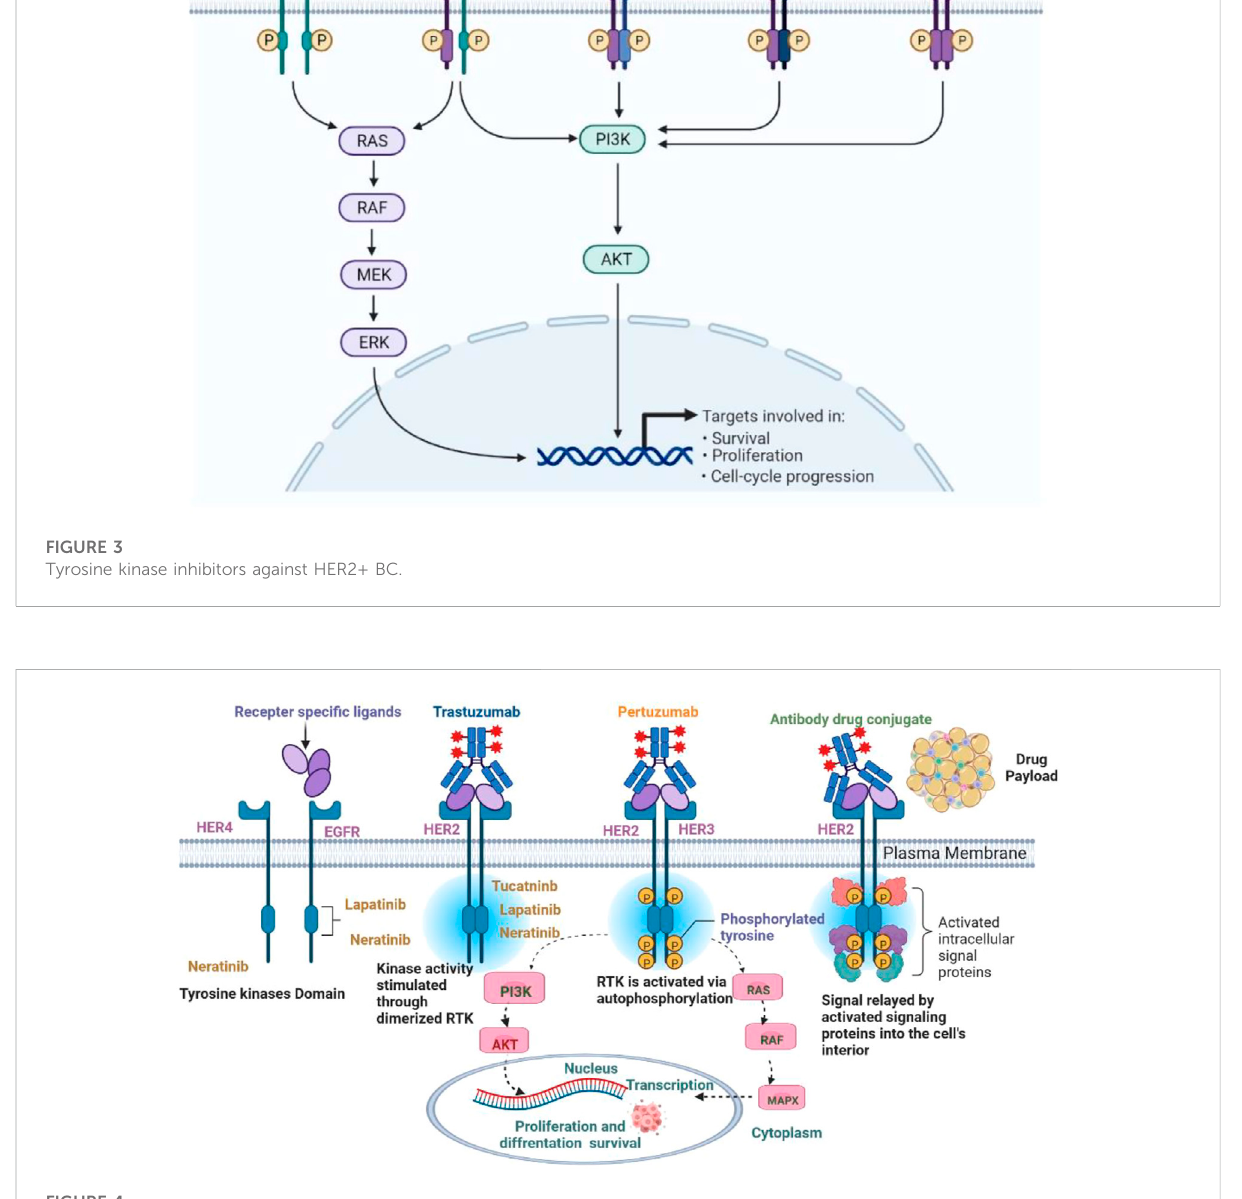
multiple targets as shown in Figures 3, 4. Sorafenib targets vascular endothelial growth factor and PDGFR (platelet- derived growth factors), which inhibit tumorigenesis as shown in Table 3 (Klempner et al., 2013; Wang et al.,